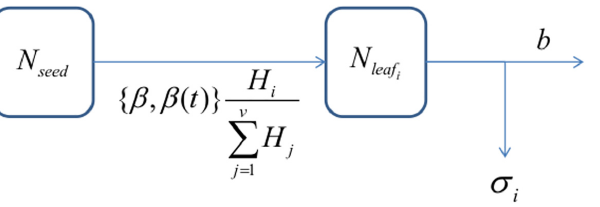
Fig 4. Flow diagram for the seed treatment fungicide sub-model. The fungicide in the seed coating ( N seed ) decreased at rate β and moved into each leaf according to the product of β and the proportion of the leaf ’ s healthy area index relative to the total canopy healthy area. Seed treatment loss from each leaf was due to senescence and catabolism, at rates σ and υ respectively.